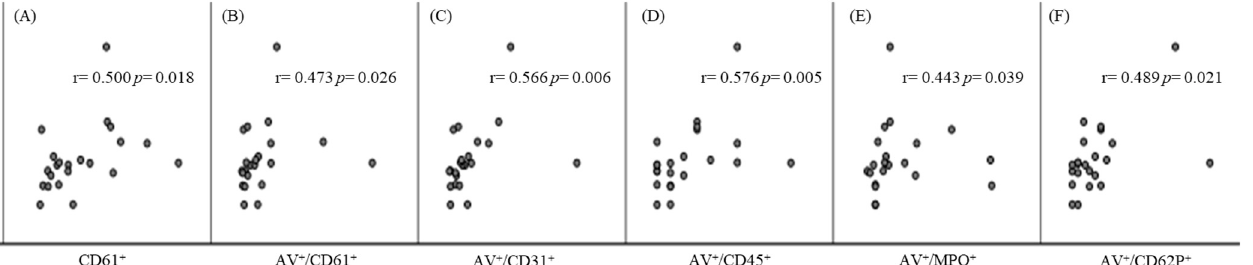
Figure 1. Scatterplots visualizing the correlations between NLRP3 gene expression in thrombi and circulating CD61 + MVs ( A ) and AV + MVs derived from platelets ( B , F ), leukocytes ( D ), endothelial ( C ), and MPO + ( E ) cells. Abbreviations: